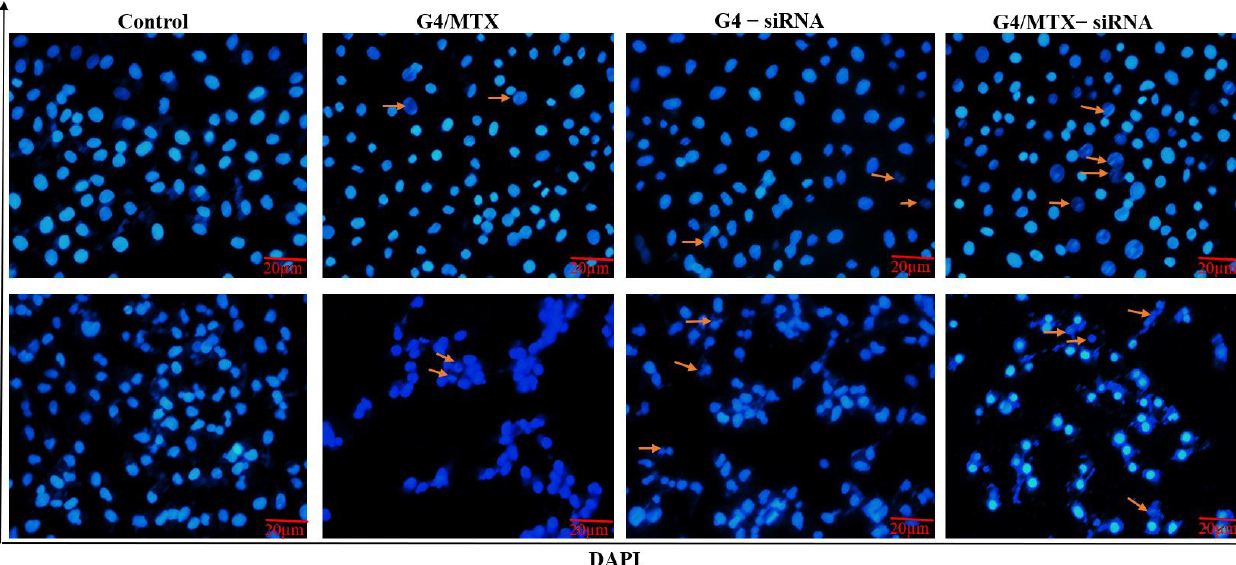
Figure 6. Apoptosis histogram with apoptosis percentage of MCF-7 ( a ) and MDA-MB-231 ( b ) cancer cells analyzed by flow cytometry using annexin V/PI staining after incubating with (IC25 concentration) of MTX, G4/MTX, G4-siRNA and G4/MTX-siRNA treatment groups for 48 h. G4 dendrimer amount was 40 µg/mL. Untreated cells were used as a negative control (* p values < 0.05 and ** p values < 0.01).